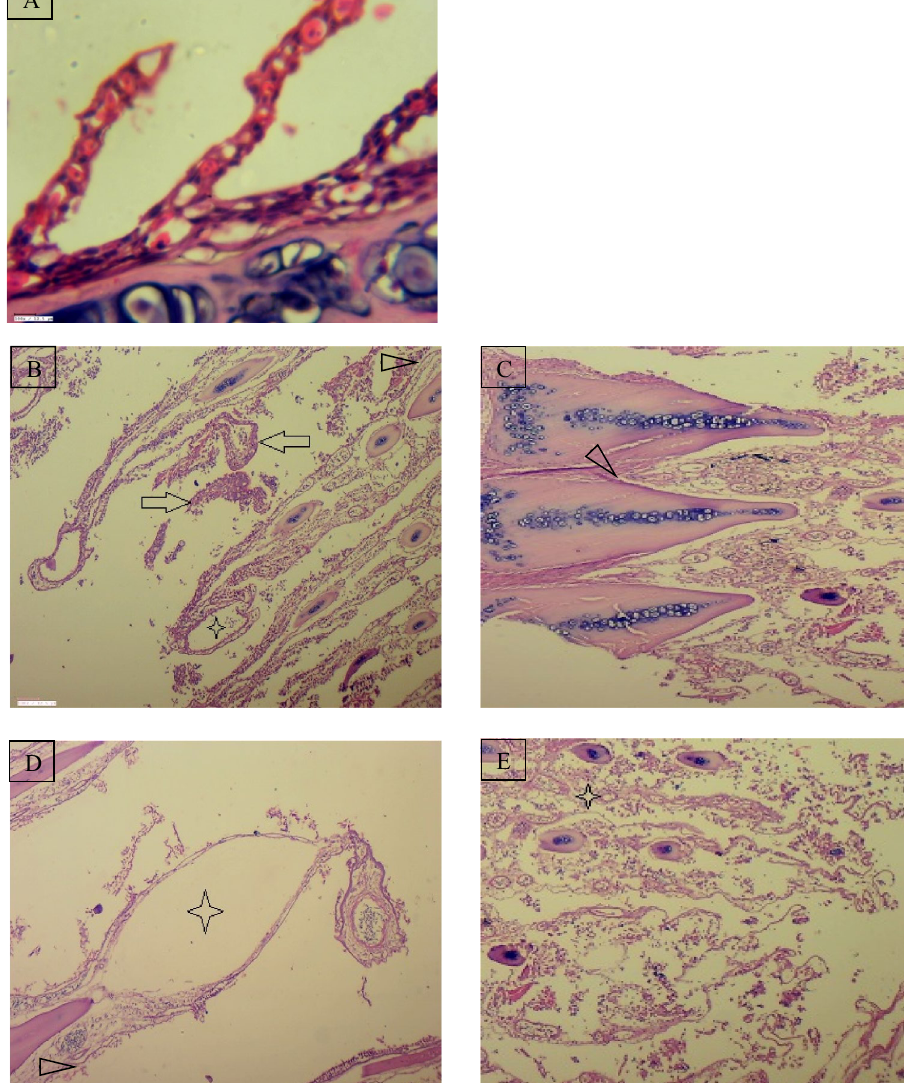
Figure 6. ( A ) Regular shaped secondary gill lamellae in control fish, Gill tissue of Rita rita (Narora) ( B ) Sloughing of lamellar epithelium and their disruption (Arrow), Lamellar congestion (Arrow head), ( C ) Gill bridging (Arrow head). Gill tissue of Rita rita (Rishikesh), ( D ) Dilated vessel (Star), Lamellar congestion (Arrow head) ( E ) Focal area of lamellar fusion and their disruption